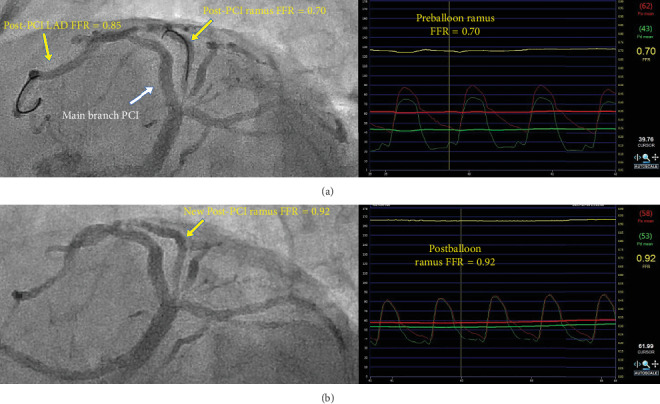
Use of post-PCI FFR for side branch assessment and optimization. (a) Suboptimal post-PCI FFR in the ramus (side branch) following bifurcation PCI, warranting further intervention. The pressure curve from this FFR measurement can be seen on the right. (b) Following kissing balloon dilation, post-PCI FFR in the ramus is improved.